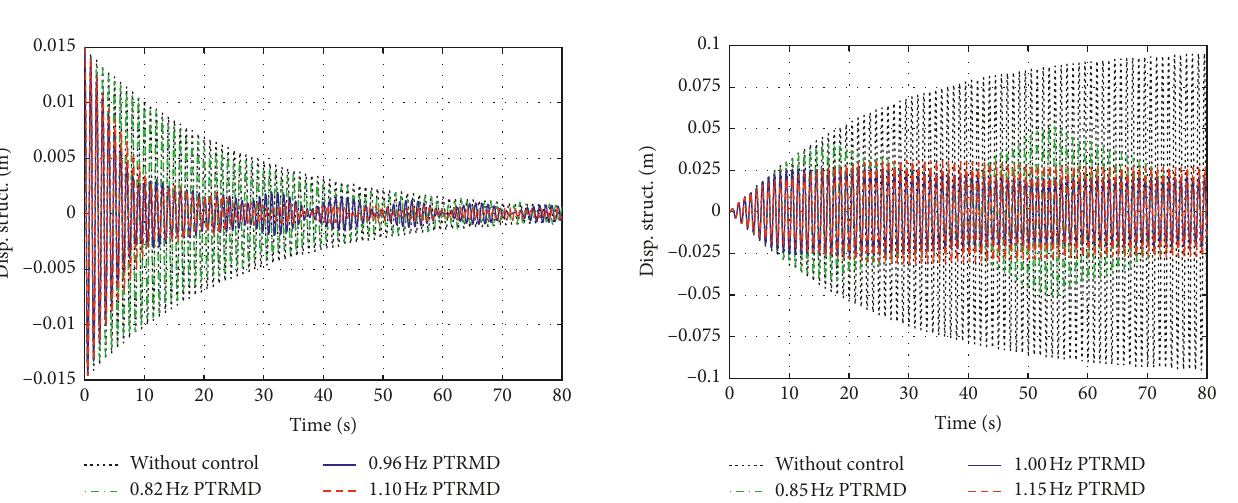
Figure 21: Response of structure controlled by PTRMD with different frequencies for forced vibration.